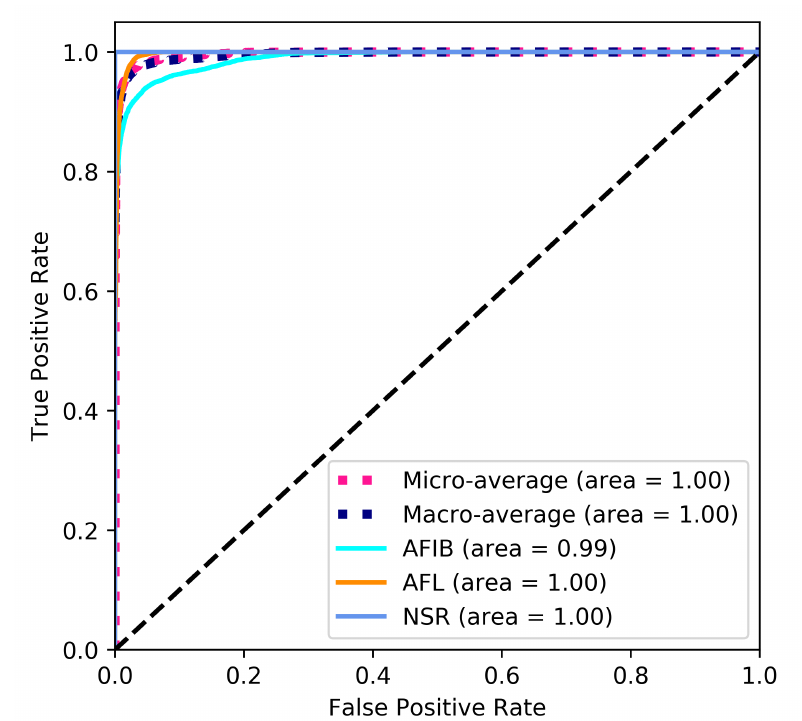
Figure 4. ROC curve based on the results from all 10 folds.